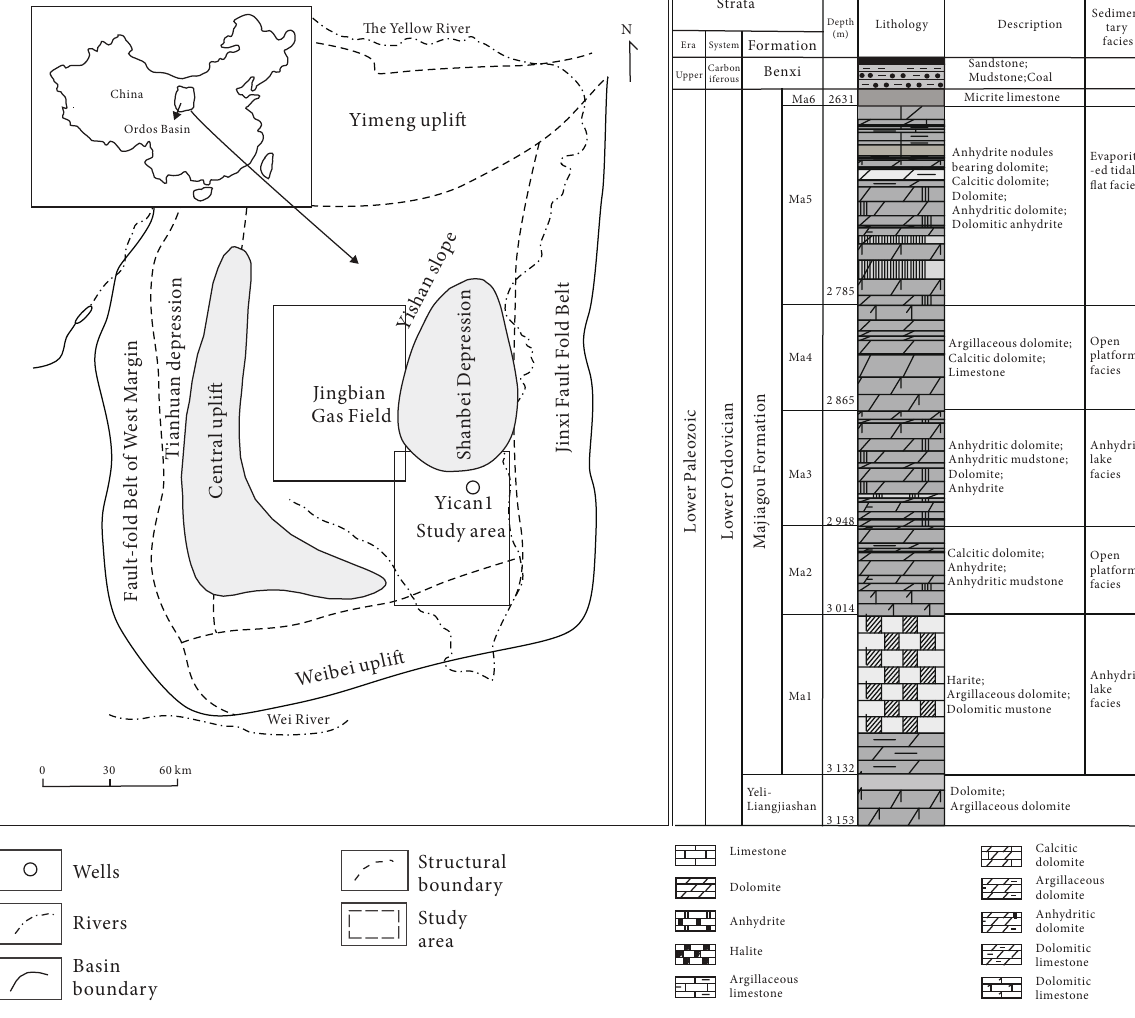
Figure 1: Simpli fi ed structural map of the Ordos Basin showing the study area and the Jingbian Gas Field [6] and the lithocolumn of the main sampled Yican 1